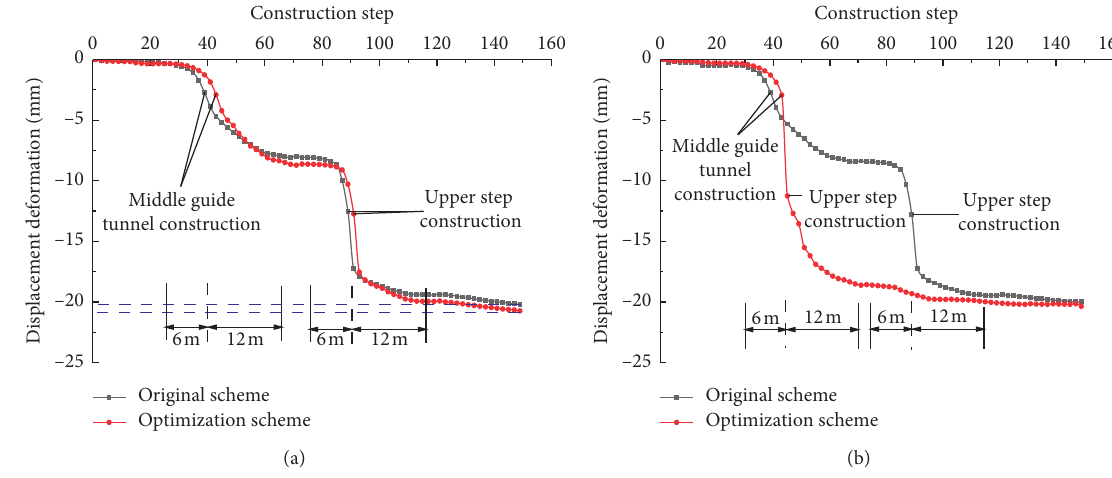
Figure 12: Comparison and analysis of arch deformation at RK0+280: (a) right tunnel vault and (b) left tunnel